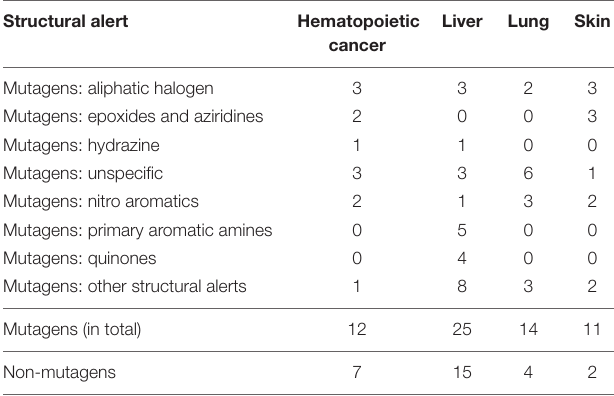
Frontiers in Pharmacology |